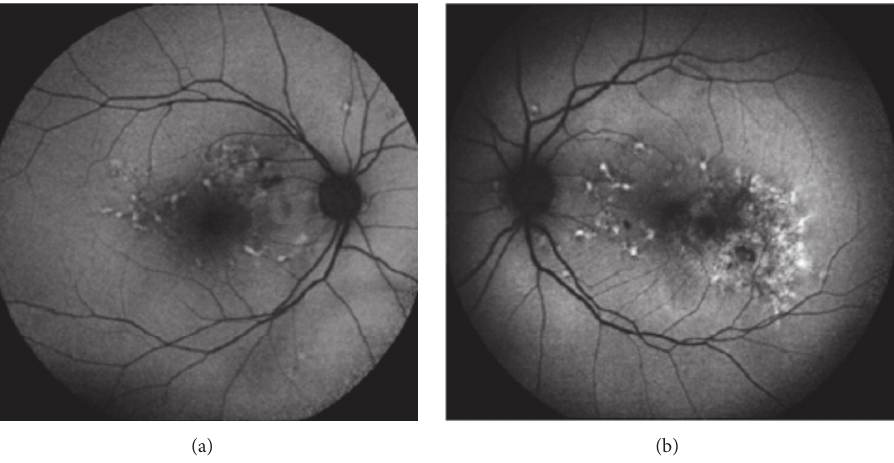
Figure 1: Autofluorescence images of the patient showing mottled loss of autofluorescence in the temporal side of the fovea (b) and hyperautofluorescence deposits (characteristic lesions in pattern dystrophy patients) on the nasal side of the fovea. Corresponding autofluorescence image from the right eye (a), showing the typical hyperautofluorescent deposits around the fovea.